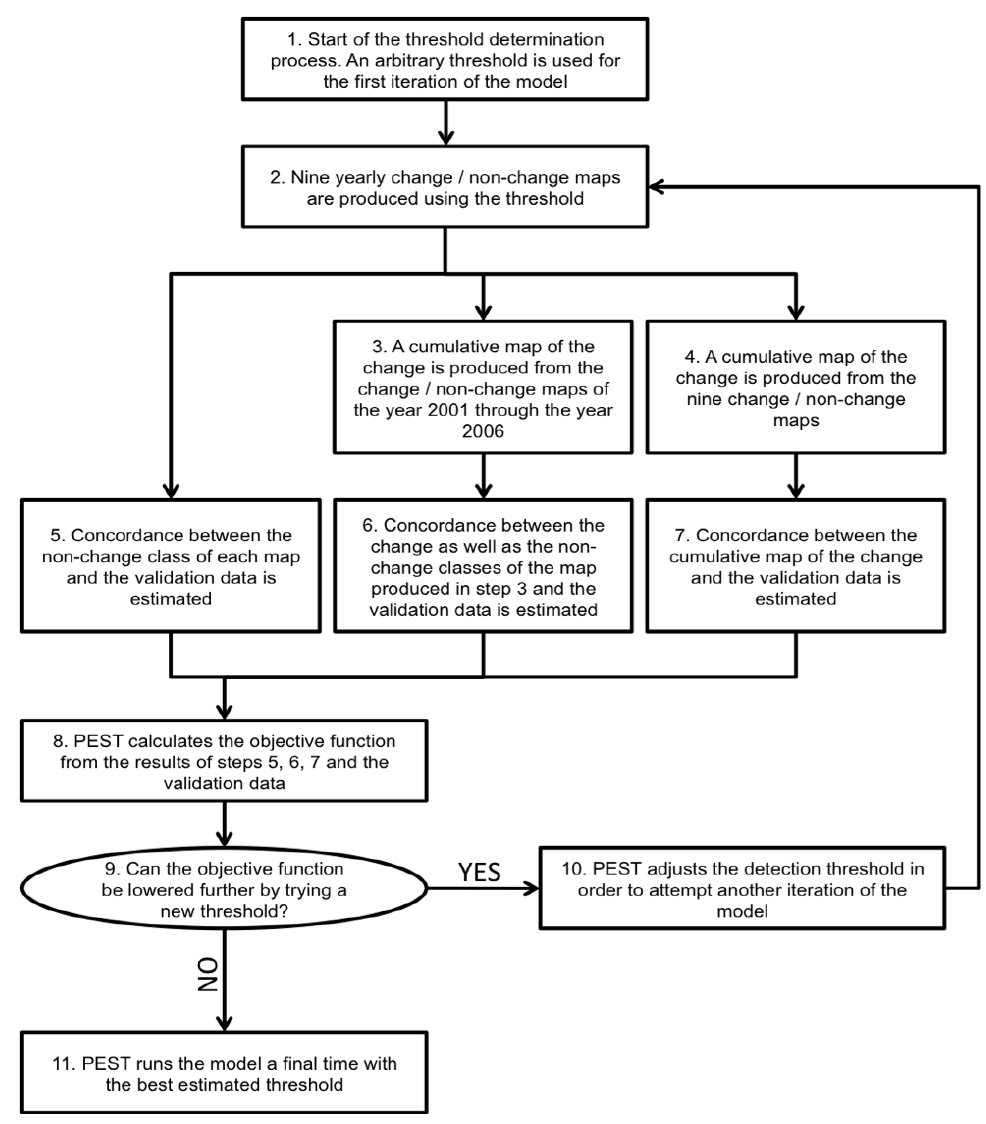
Figure 3. Threshold determination workflow using the PEST software